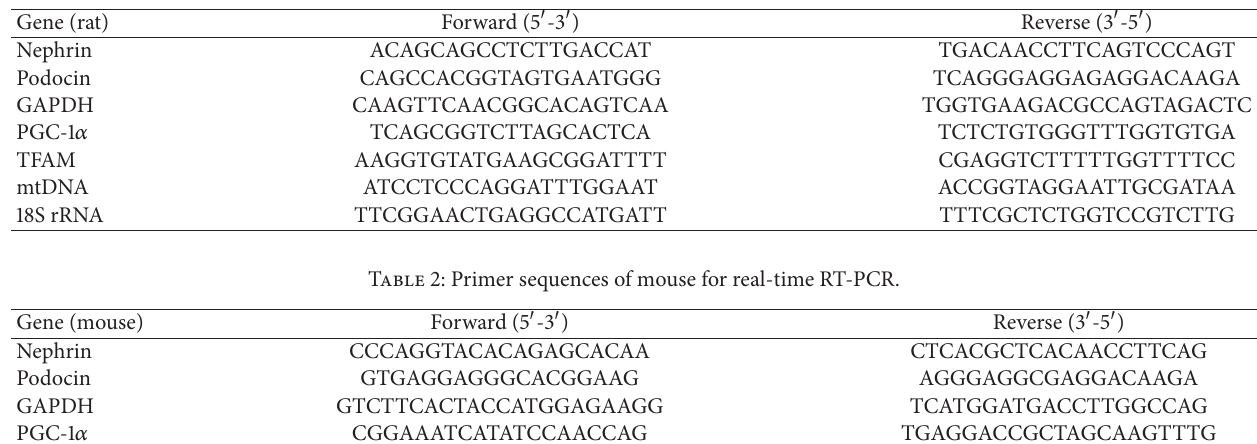
Table 1: Primer sequences of rat for real-time RT-PCR.